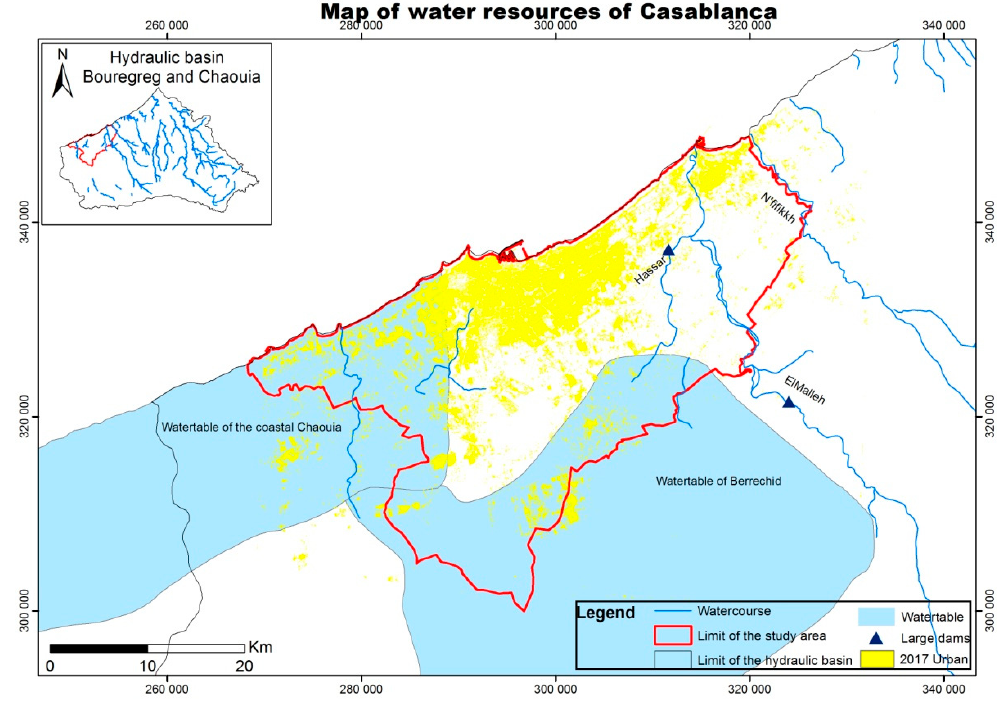
Figure 6. A map of water resources of Casablanca.